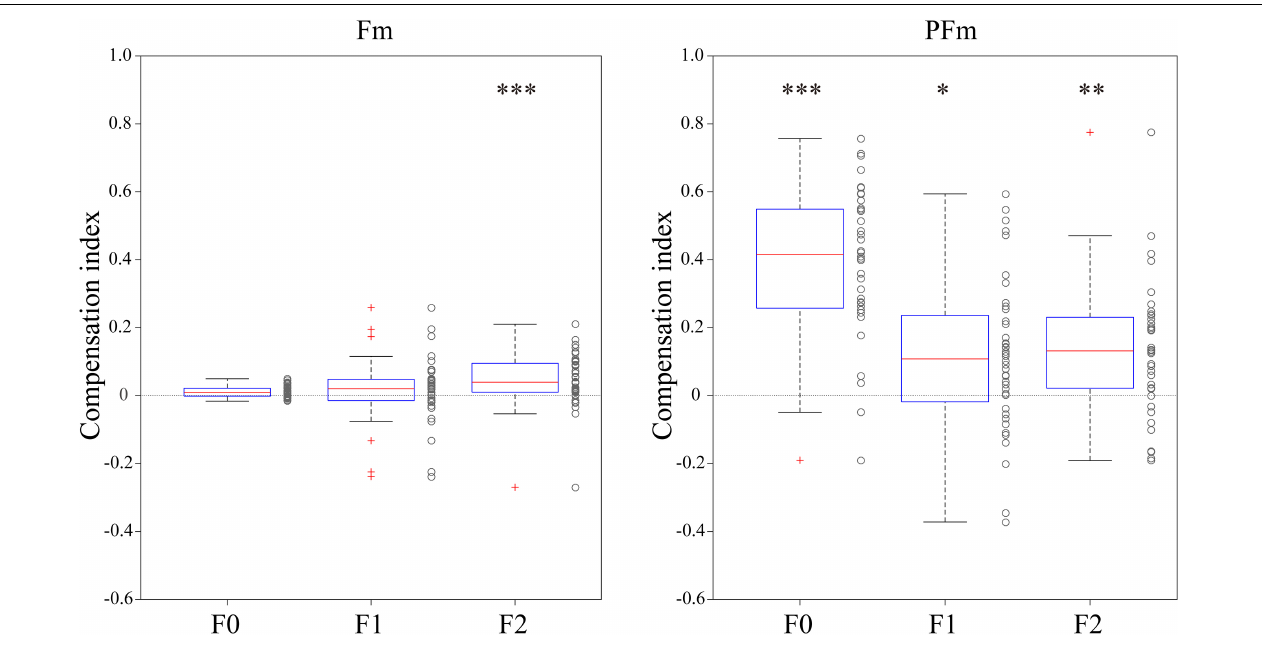
FIGURE 3 | The compensation index for each participant in both types of AF modification conditions. The left panel shows the results in the Fm conditions and the right panel shows those in the PFm conditions. Box plots of compensation indexes were created for each parameter (F0, F1, and F2). The asterisks indicate the statistical significance of the binomial tests (* p < 0.05, ** p < 0.01, and *** p < 0.001). The p- values of the 6 binomial tests were adjusted using Bonferroni’s correction.